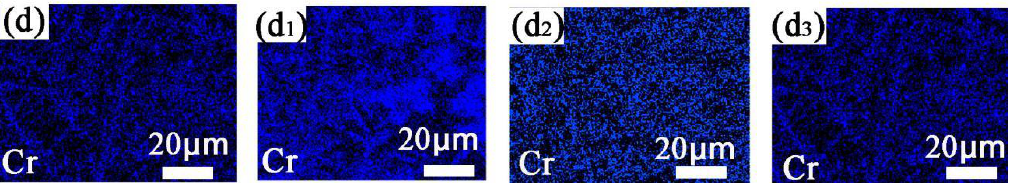
Figure 4. Element distribution of the composite coatings with different heat-treatment temperatures: ( a – d ) 25 ◦ C; ( a 1 – d 1 ) 500 ◦ C; ( a 2 – d 2 ) 600 ◦ C; ( a 3 – d 3 ) 700 ◦ C.